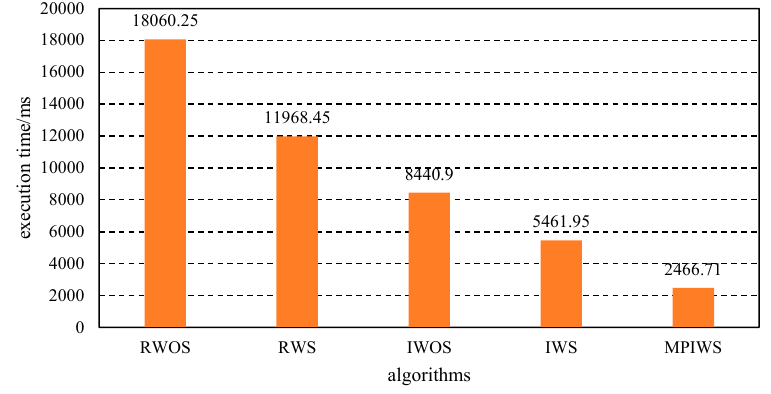
Figure 8. Execution time of four algorithms.